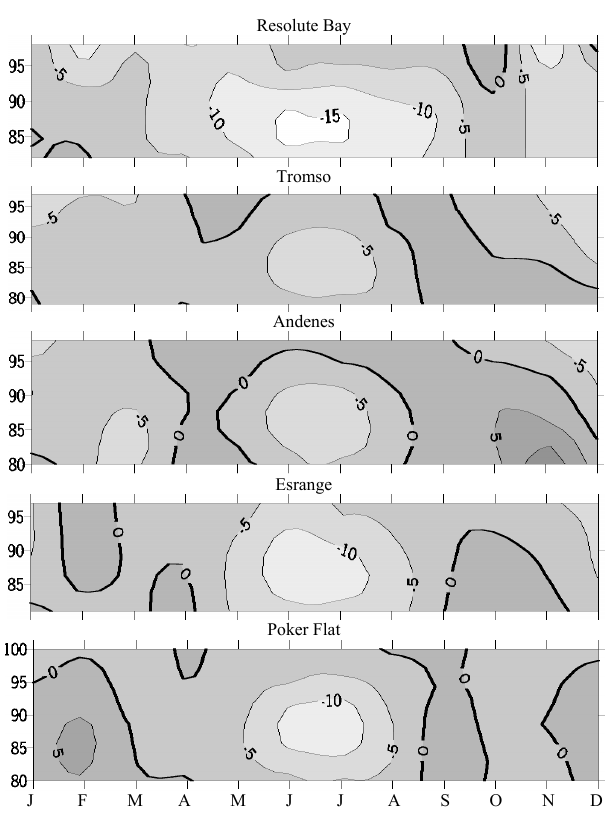
Fig. 6. As Fig. 4, but for monthly mean meridional wind.